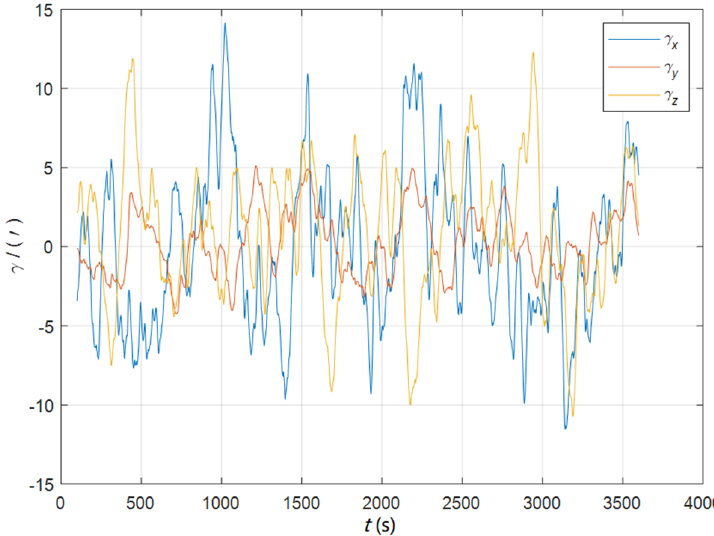
Figure 25. The curves of the dynamic deflection angle in the dynamic swing base. In the case of large and small initial misalignment angles, the curves of the static deformation angle µ are shown in Figures 26–28.